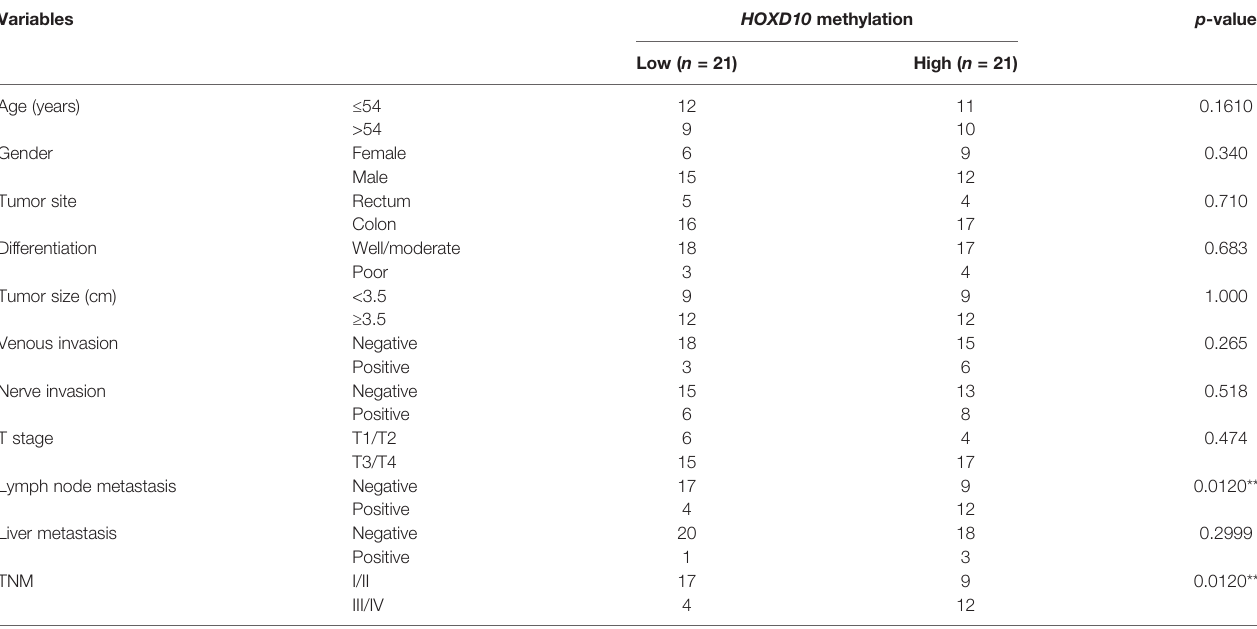
TABLE 1 | Correlation between HOXD10 methylation and clinicopathologic features.